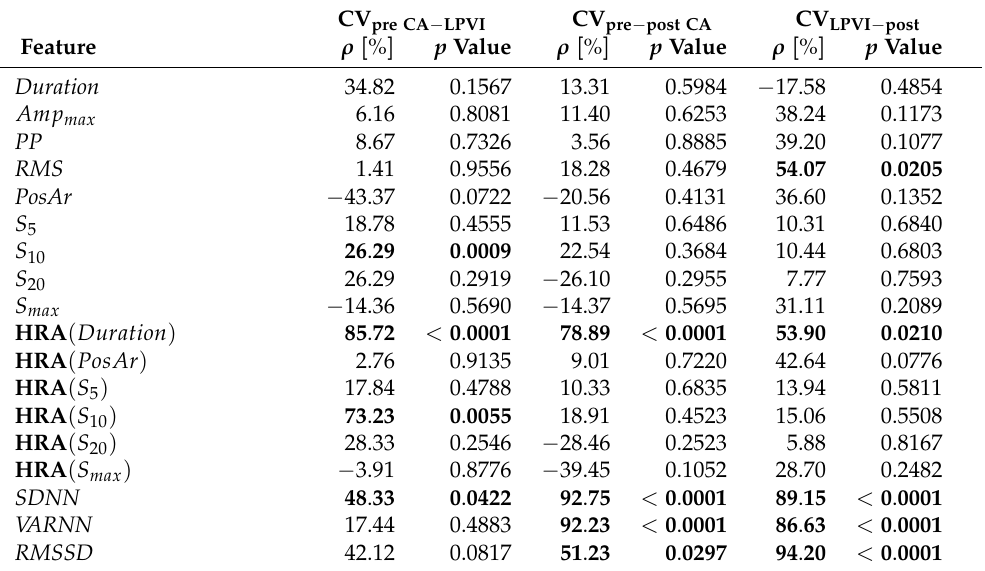
Table 3. Pearson’s correlations (%) and p values between LAWs and P-waves for CV measured every two ablation steps. Statistically significant results are shown in bold . CV: correlation of variation.